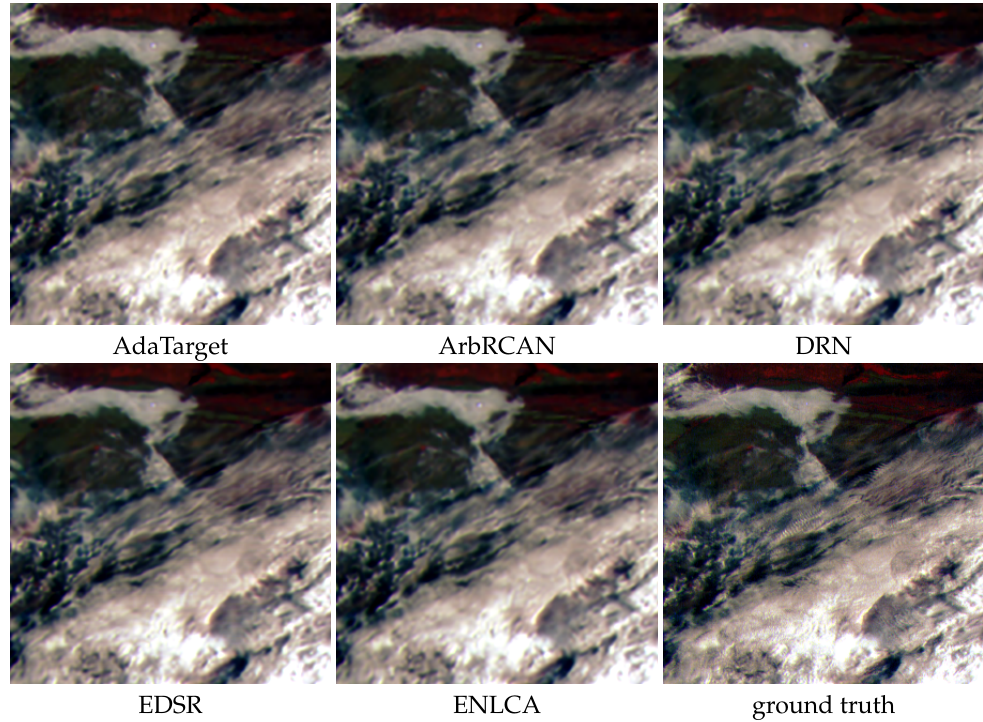
Figure 15. Local manifestation of the super-resolution results on the FY4ASRcolor dataset: Patch